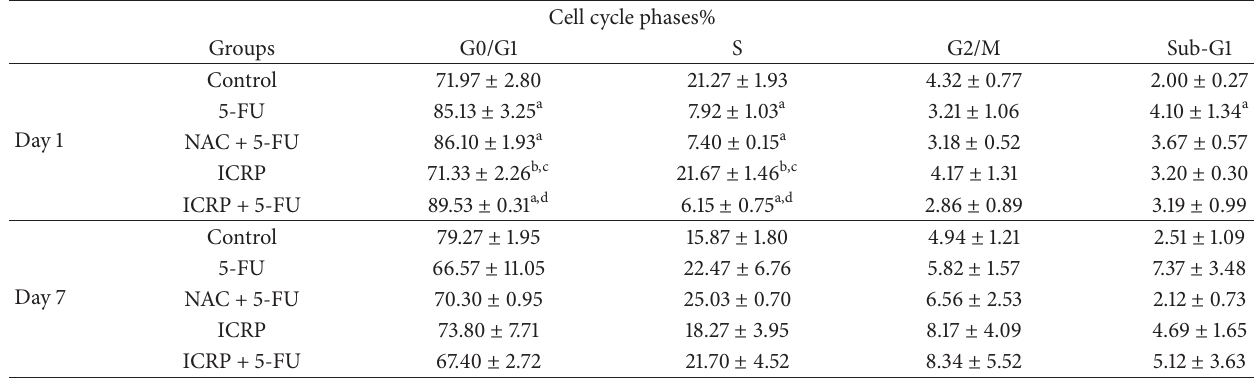
Erythrocyte population%